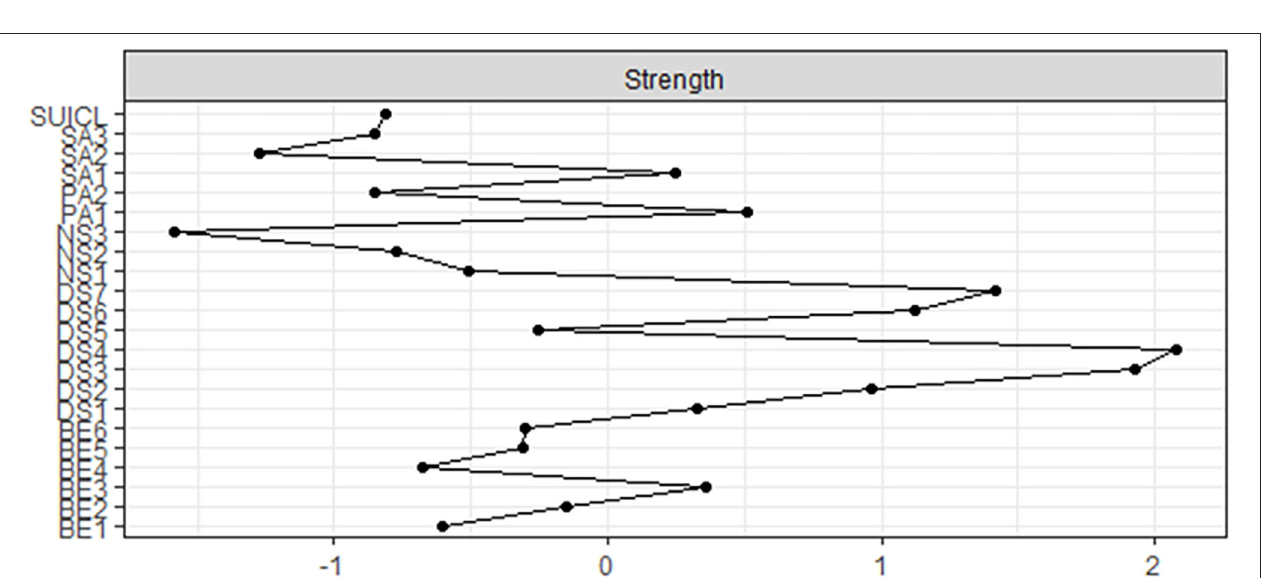
FIGURE 2 | Representation of network model of psychotic experiences, suicidal ideation, and depressive symptoms (BE, bizarre experiences; PA, perceptual anomalies; SA, social anxiety; NS, negative symptoms); DASS, depressive symptoms, SUICL, suicidal ideation (life time). Two main components are depicted: the symptoms or nodes (circles), and the edges (lines linking the symptoms). The edges represent the relationships between symptoms (green lines correspond to positive associations). The thickness of the edges represents the magnitude of the associate ion between nodes.